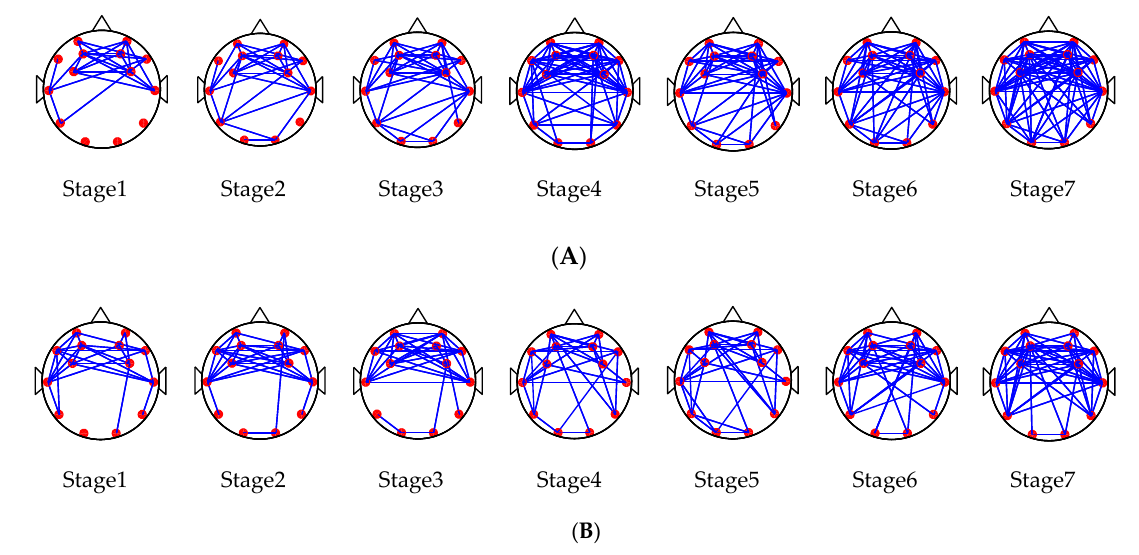
Figure 7. ( A ) Changes of Brain Network Connections at all driving stages (1–7) in normal driving mode; ( B ) Changes of Brain Network Connections at all driving stages (1–7) in Man-machine Response mode.